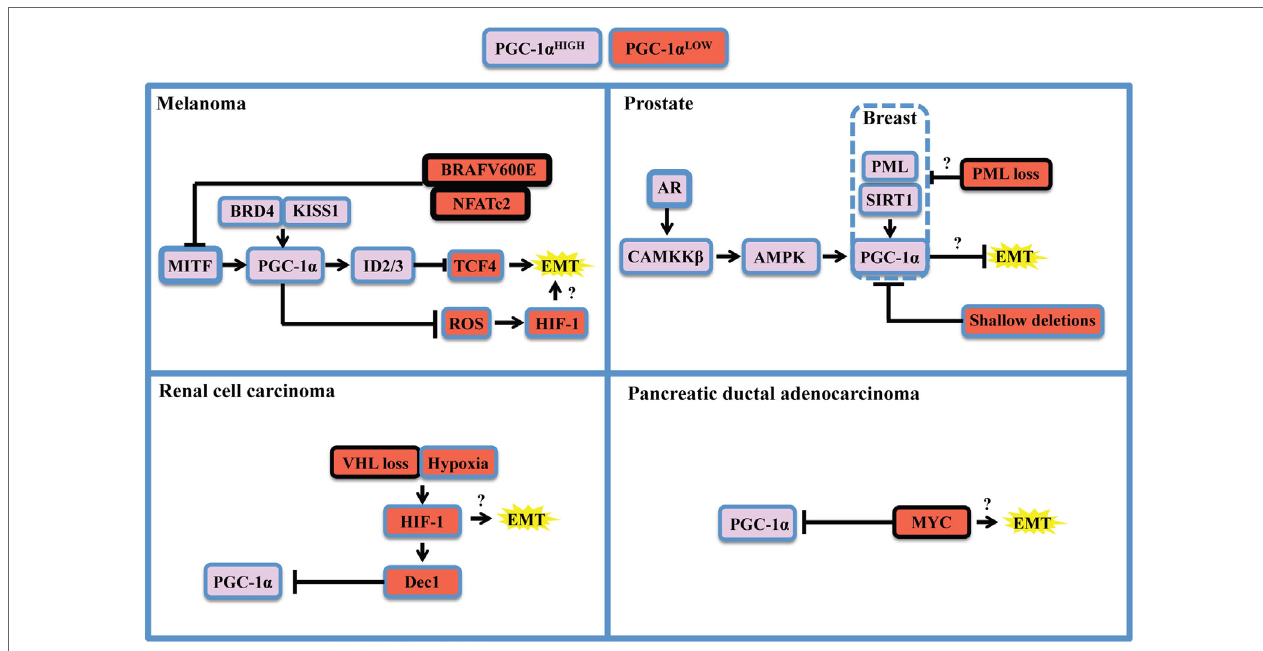
FiGURe 2 | Oncogenic and context-specific determinants that modulate PGC-1 α in cancer. The expression of PGC-1 α is influenced by the presence of oncogenes, the loss or dysfunction of tumor suppressors, and the expression of lineage-specific regulators. Context-specific regulation depends on the expression of lineage-specific modulators, such as microphtalmia-associated transcription factor (MITF) in melanoma, or the expression of the androgen receptor (AR) in prostate cancer. It is also function of cellular stresses, such as limitation in nutrient supply, hypoxia, and redox state, and will depend on the activity of the SIRT1 deacetylase and the AMP kinase (AMPK) that will potentiate PGC-1 α transactivating functions and might modify its gene expression programs. The oncogenic landscape [BRAF mutation, MYC amplification, VHL, or promyelocytic leukemia (PML) loss] will regulate PGC-1 α expression at the transcriptional level, likely through direct binding of transcriptional inhibitors to the PPARGC1A promoter. Cumulating evidences support the notion that PGC-1 α and mitochondrial OXPHOS are antagonistic to the establishment of the epithelial-to-mesenchymal transition (EMT). One mechanism supporting the inhibitory role of PGC-1 α on EMT is through induction of Inhibitors of DNA binding (ID) proteins 2 and 3 that suppress TCF4, an important modulator of EMT. Therefore, oncogenic signaling could relieve EMT inhibition by downregulating PGC-1 α and OXPHOS. By suppressing reactive oxygen species (ROS) though transcriptional regulation of antioxidant genes, PGC-1 α exerts antagonistic effects on hypoxia-inducible factor 1 α (HIF-1 α ). These findings converge to delineate the existence of critical rheostats opposing the expression of PGC-1 α to the one of oncogenes and pro-glycolytic transcription factors such as HIF-1 α . Question marks underline unknown links in the specified cancers in the context of PGC-1 α